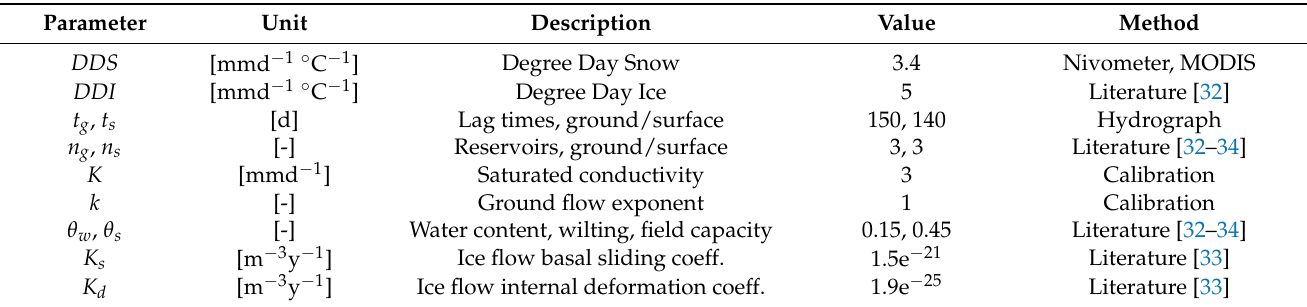
Table 1. Parameters in calibration of Poli-Hydro